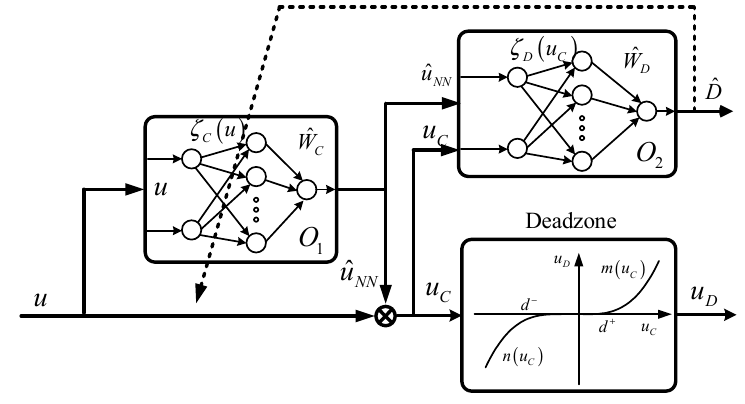
Figure 4. Dead zone compensation scheme.